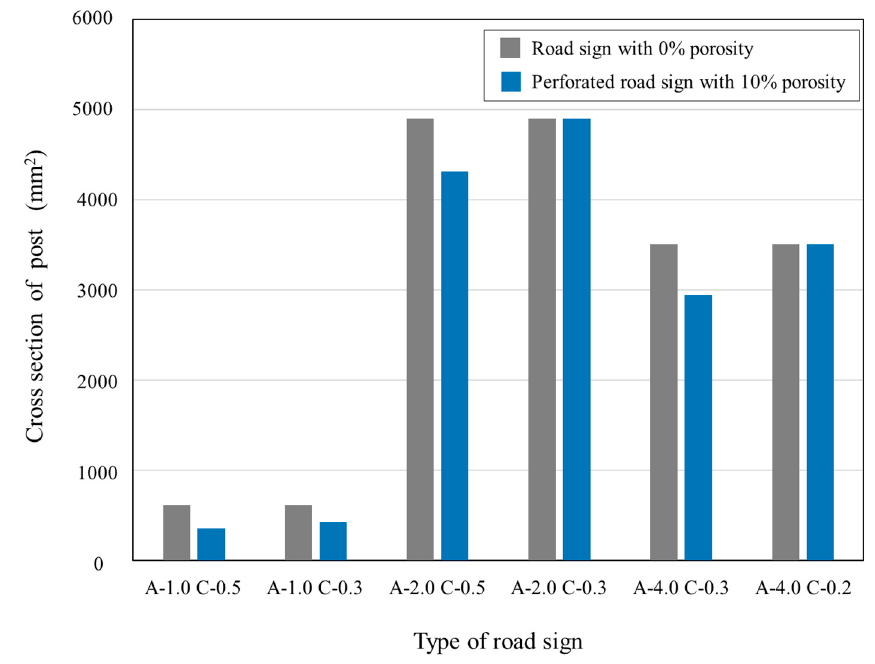
Figure 14. Effect of reducing the cross section of perforated road sign post.